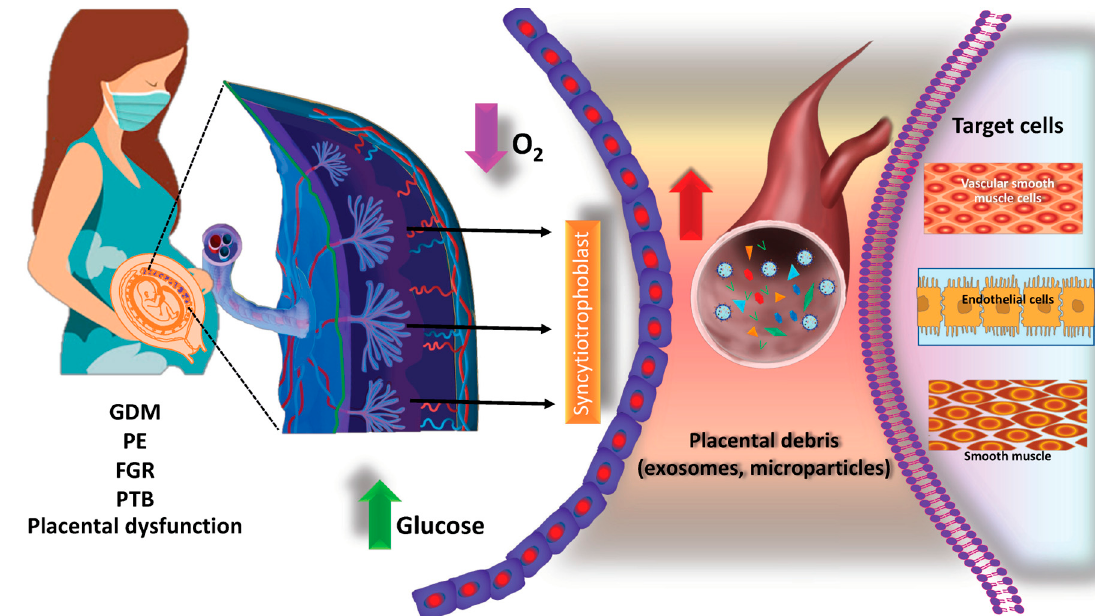
Figure 4. Potential roles of placental debris and exosome changes during pregnancy-related com- plications. Placental debris and EVs (including exosomes and microvesicles) released from the placenta under different micro-environment conditions (such as hypoxia or high glucose) and their targeting of neighboring cells in the placenta and distant organs such as skeletal muscles. EVs are released by placental cells (such as syncytiotrophoblasts, cytotrophoblasts (CTs), and extravillous trophoblasts (EVTs)) and other cells in the placenta such as the placental mesenchymal stem cells. EVs from the placenta can enter maternal circulation and target distant cells such as skeletal mus- cles, endothelial cells, or vascular smooth muscle cells. Placenta-derived EVs’ concentration, con- tent, and bioactivity changes in pregnancy and pregnancy-related disorders including GDM, PE, PTB, and FGR. GDM: gestational diabetes, PE: preeclampsia; FGR: fetal growth restriction, PTB: preterm birth.